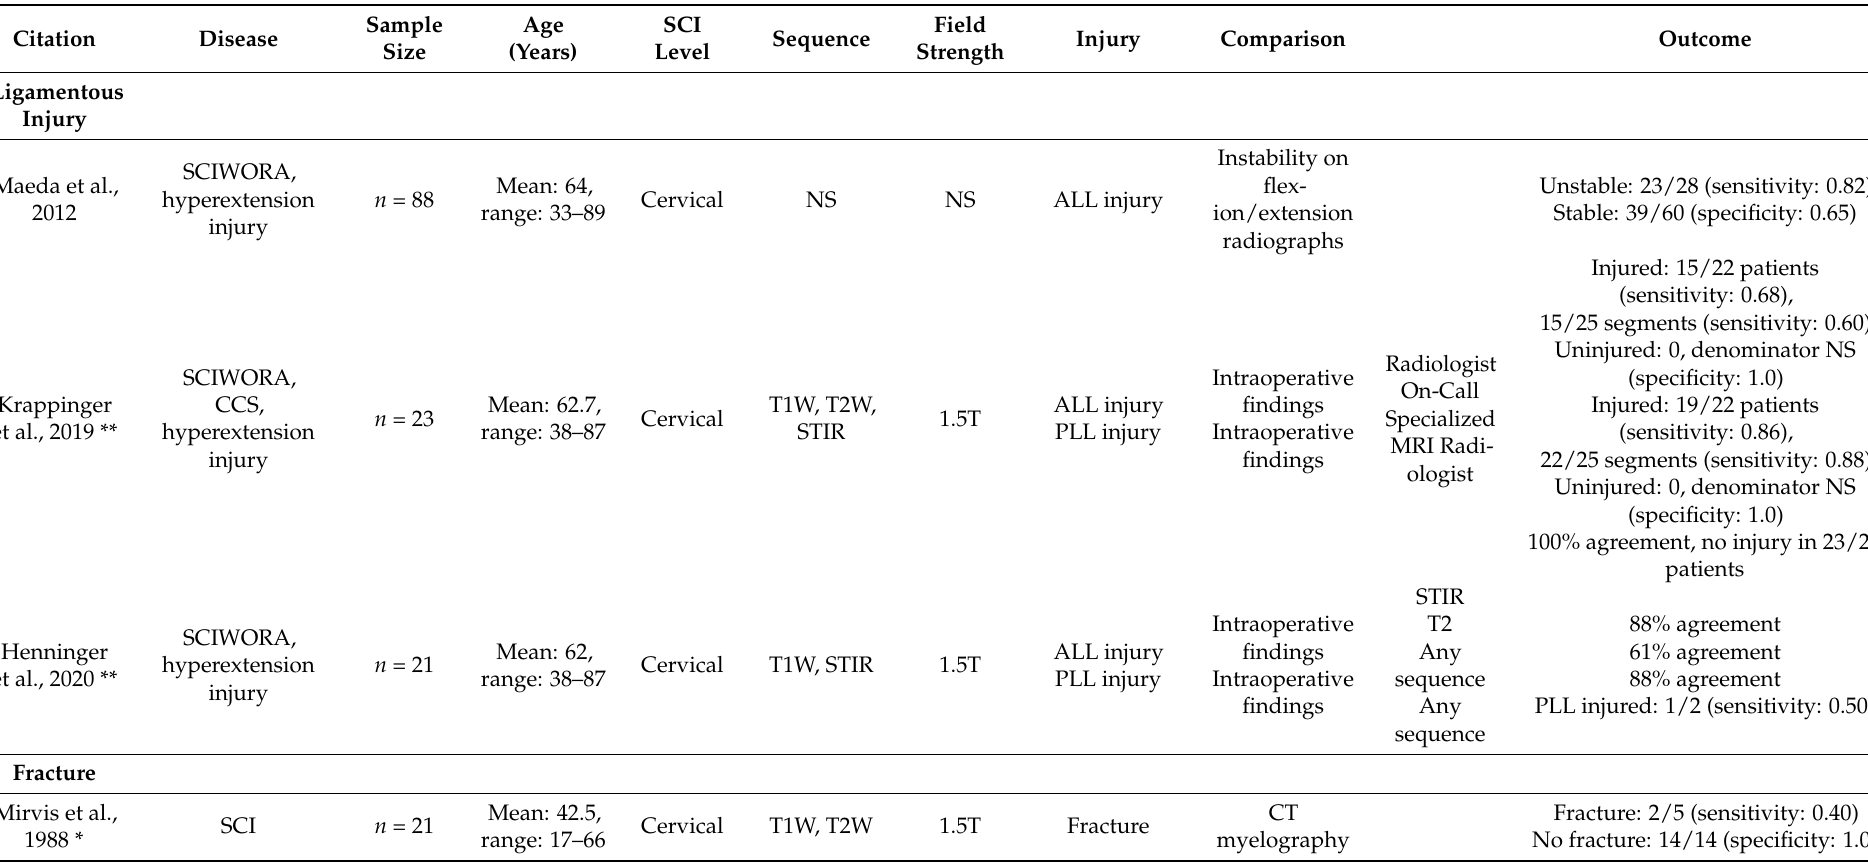
Table 3. Key Question 1: What is the diagnostic accuracy of MRI to detect specific features of spinal injury that are likely to alter clinical management in patients with acute SCI.